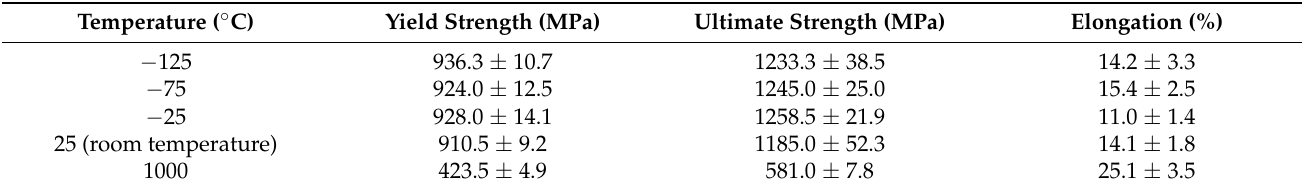
Table 1. Yield strength, ultimate strength and elongation parameters of DZ406 superalloy in the temperature of − 125 ◦ C~1000 ◦